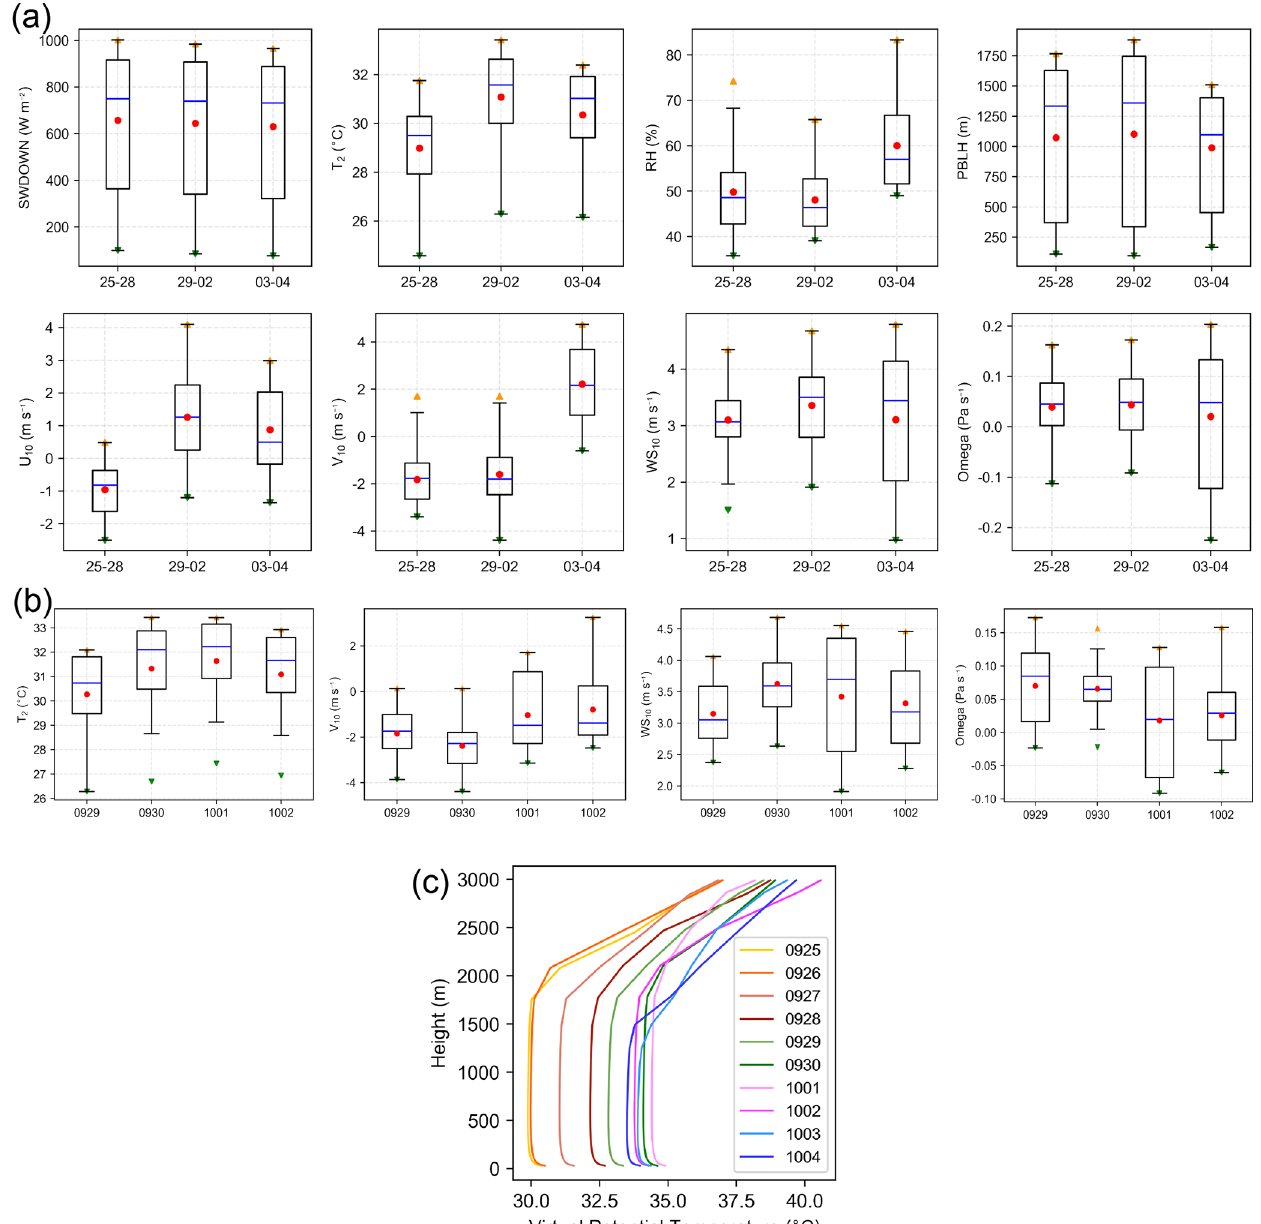
Figure 6. (a) Box plot of different meteorological parameters at the subtropical high period (25–28 September), typhoon period (29 Septem- ber to 2 October), and clean period (3–4 October). (b) Box plot of the comparisons of key meteorological parameters when Typhoon Mitag was in different locations. (c) Comparisons of virtual potential temperature ( θ v ) profiles in different periods at 14:00. The boxes in panels (a) and (b) represent the interquartile range of each meteorological parameter, the lines dividing the boxes represent the median, the whiskers represent the maximum and minimum values other than outliers, the red dots represent the mean, and the triangles represent the maxima and